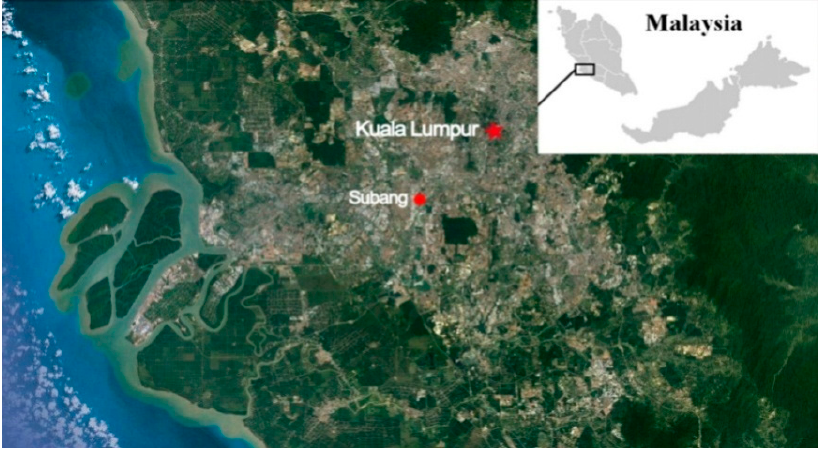
Figure 11. Map of Subang city, Malaysia.